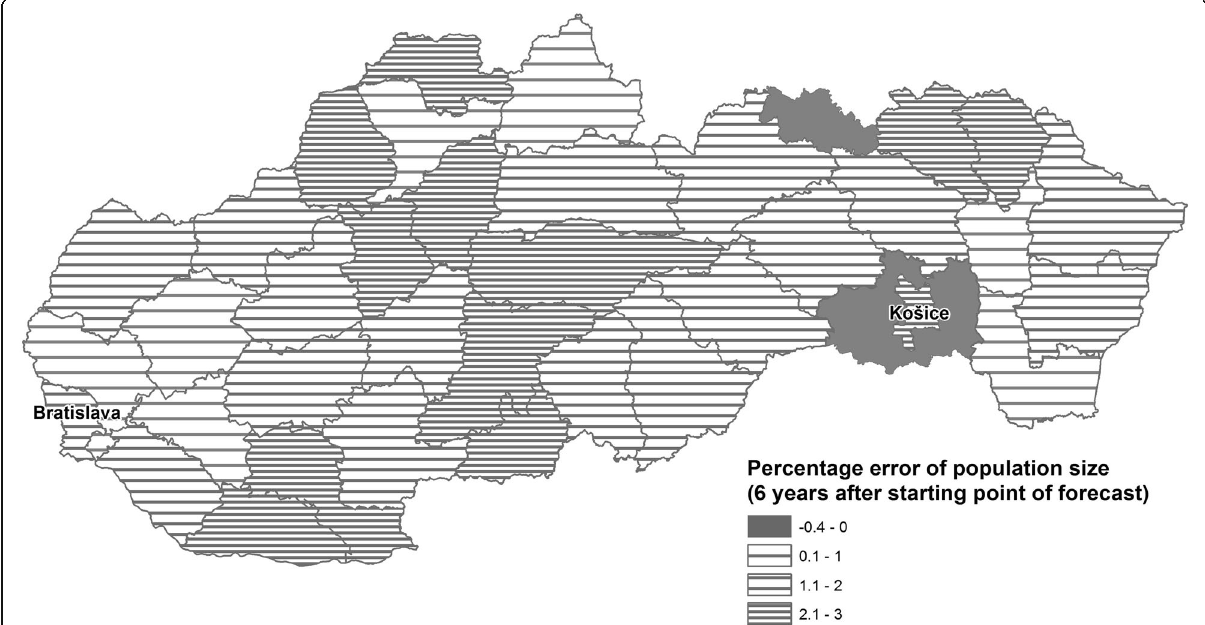
Fig. 5 Percentage error of population size in districts of the Slovak Republic. Source: [16], authors ’ calculations. Note: districts existing until 1996, calculated for year 2000 (6 years after